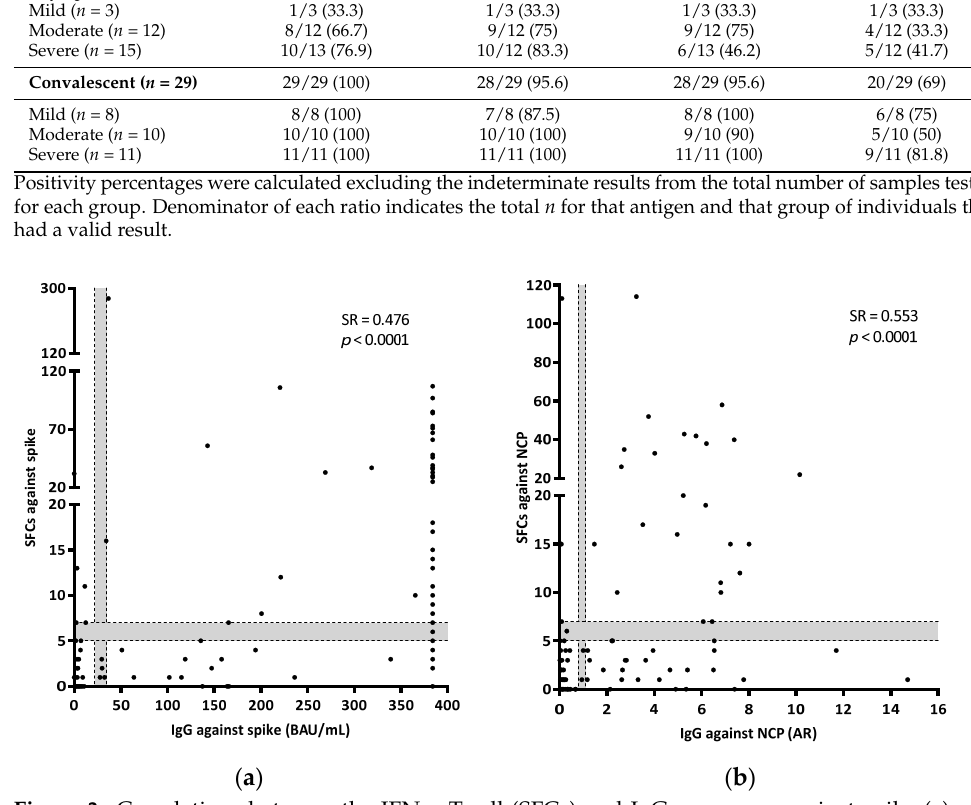
Figure 2. Correlation of the IFN- γ response against spike (SFCs) with days after the first dose of the vaccine administration ( a ). Orange dots are samples from individuals with only one dose. Correla- tion of the IFN- γ response (SFCs) in spike ( b ), NCP ( c ), and membrane ( d ) with days after diagnosis (PCR) in convalescent patients. Grey area shows borderline results. Correlations were calculated using the two-tailed non-parametric Spearman test.